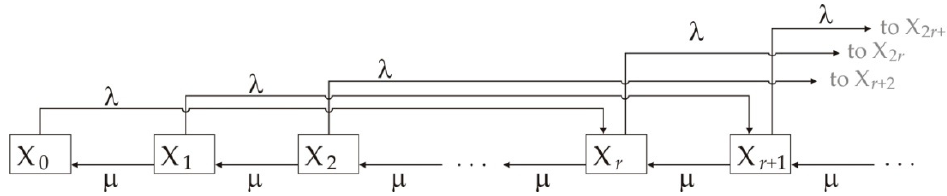
Figure 1. Flow diagram of the M / E r / r current